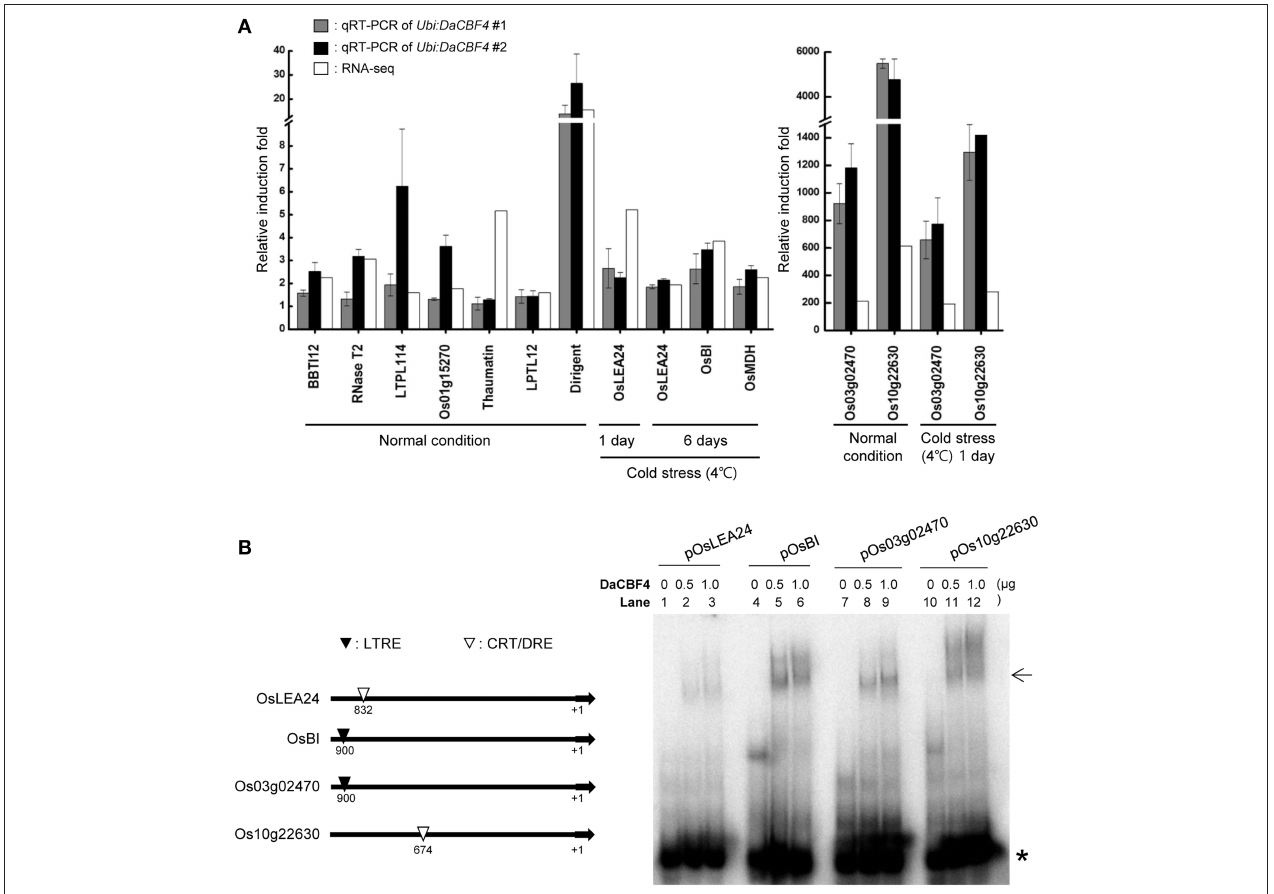
FIGURE 6 | Validation of the gene expression profiles obtained in RNA-seq by RT-qPCR and gel retardation analysis. (A) Light-grown, 6-week-old wild-type and Ubi:DaCBF4 plants were subjected to cold (4 ◦ C) stress for 1 day and 6 days, respectively. DEGs commonly up-regulated in Ubi:DaCBF4 and Ubi:DaCBF7 transgenic plants under normal condition or cold stress condition were confirmed by RT-qPCR using the gene-specific primers listed in Supplementary Table 2. Data represent the fold induction of each gene in Ubi:DaCBF4 #1 and #2 plants relative to wild type plants. Gray bars show relative gene expression of Ubi:DaCBF4 #1 normalized to the level of OsActin mRNA as an internal control, which indicate means ± SD from three biological replicates. In addition, black bars indicate relative induction fold of Ubi:DaCBF4 #2, which indicate means ± SD from biological duplicates. White bars represent fold change of the selected genes in RNA-seq. (B) Gel retardation assay. (Left panel) Schematic presentation of four DaCBF4-induced target genes. + 1 indicates a transcription initiation site. Putative CRT/DRE and LTRE motifs are indicated by ∇ and H , respectively. (Right panel) Gel retardation assay was performed with the 32 P-radiolabeled promoter sequence of OsLEA24 (lanes 1-3),